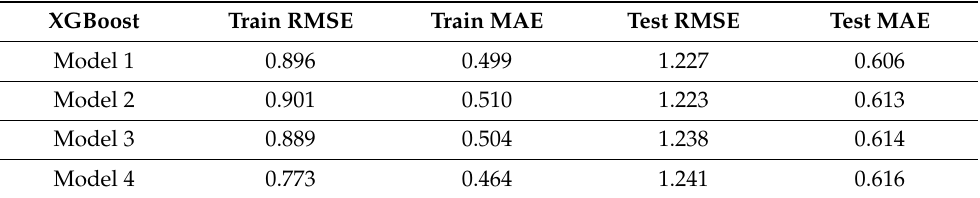
Table 12. Train and test RMSE and MAE for all XGBoost models.